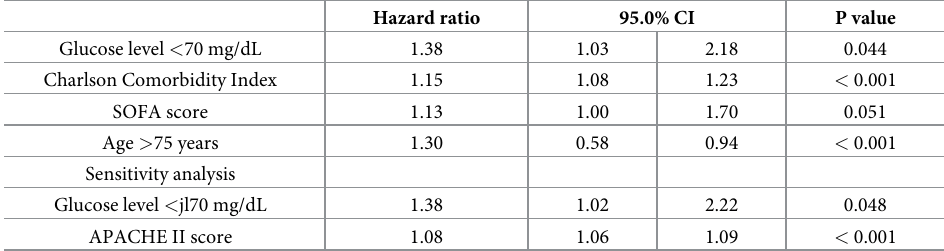
Table 5. Cox regression analysis for the duration of survival (forced entry